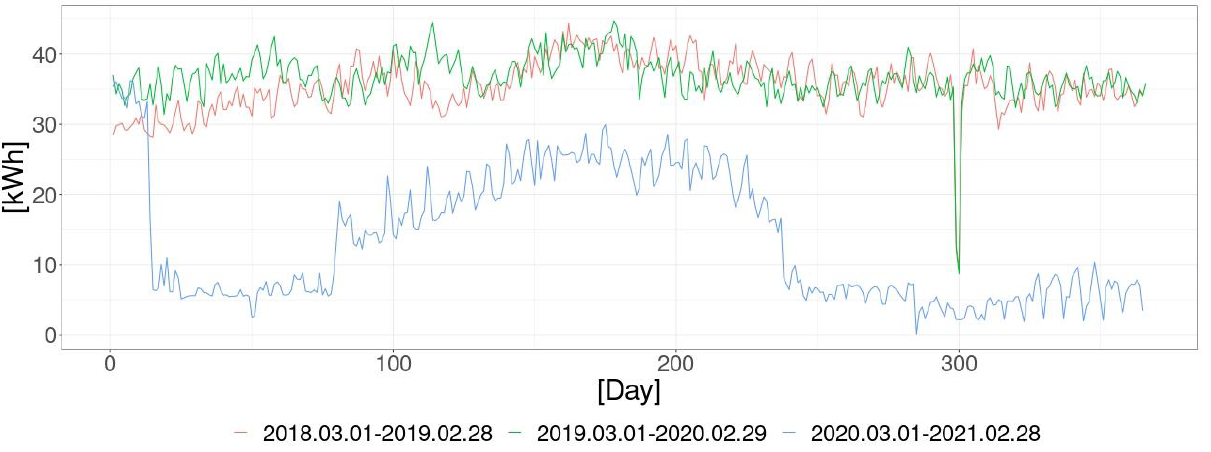
Figure 4. Daily demand for electricity in restaurants in individual analysis periods.